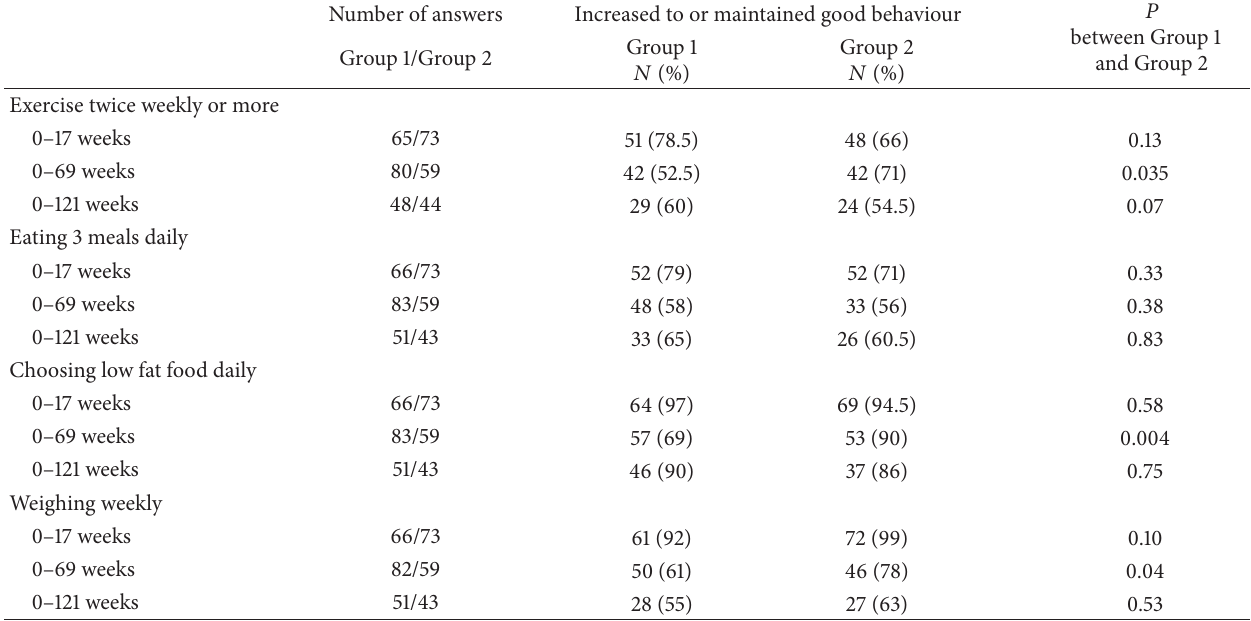
Table 3: Change in self-reported weight related behaviours of those who successfully filled in questionnaires in Group 1 (17-week program) and Group 2 (17-week program with